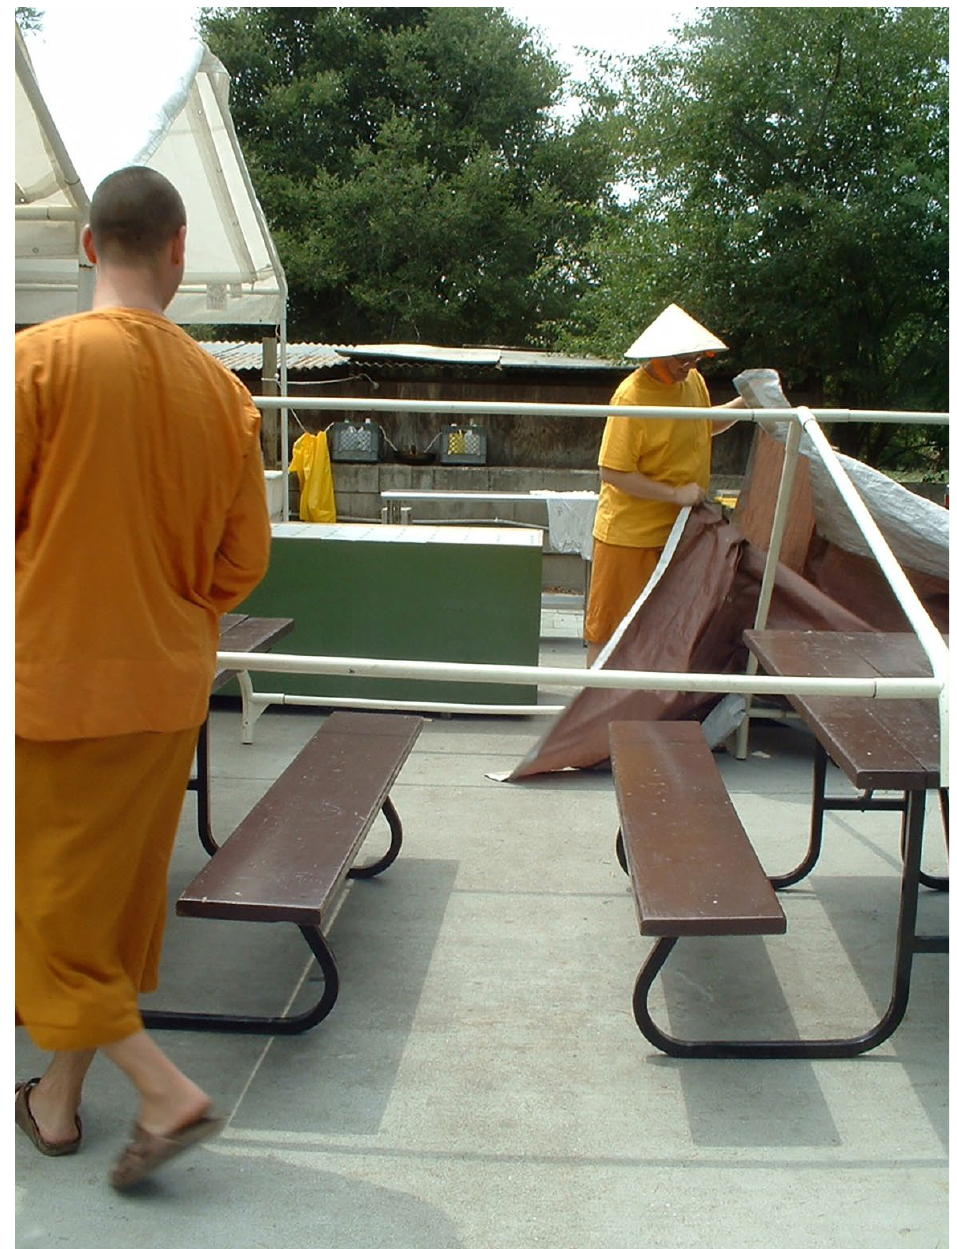
Figure 4: Monks setting up a tent for the food court (photograph by the author, 2006) Thai monks, too, have engaged in many facets of community life, including supporting the operation of a food court. At Wat Thai of Silicon Valley, monks help prepare food for communal events behind the scenes. One monk may be in charge of shopping for supplies for the food court; another monk, soaking and steaming rice at 6 a.m.; and another may be in charge of cleaning the dining tables before 7 a.m. Then they work together at tasks such as setting up tents at the food court (see figure 4). At dawn on April 10, 2009, I happened upon an unexpected sight at the food court: five monks were slicing papaya in preparation for celebrating Thai New Year. 28 Their action silently 28 Another example: the abbot of Wat Thai Las Vegas told me that, after a big community event, he led his monks in making noodle soup for the lay volunteers to thank them for their hard work on behalf of the